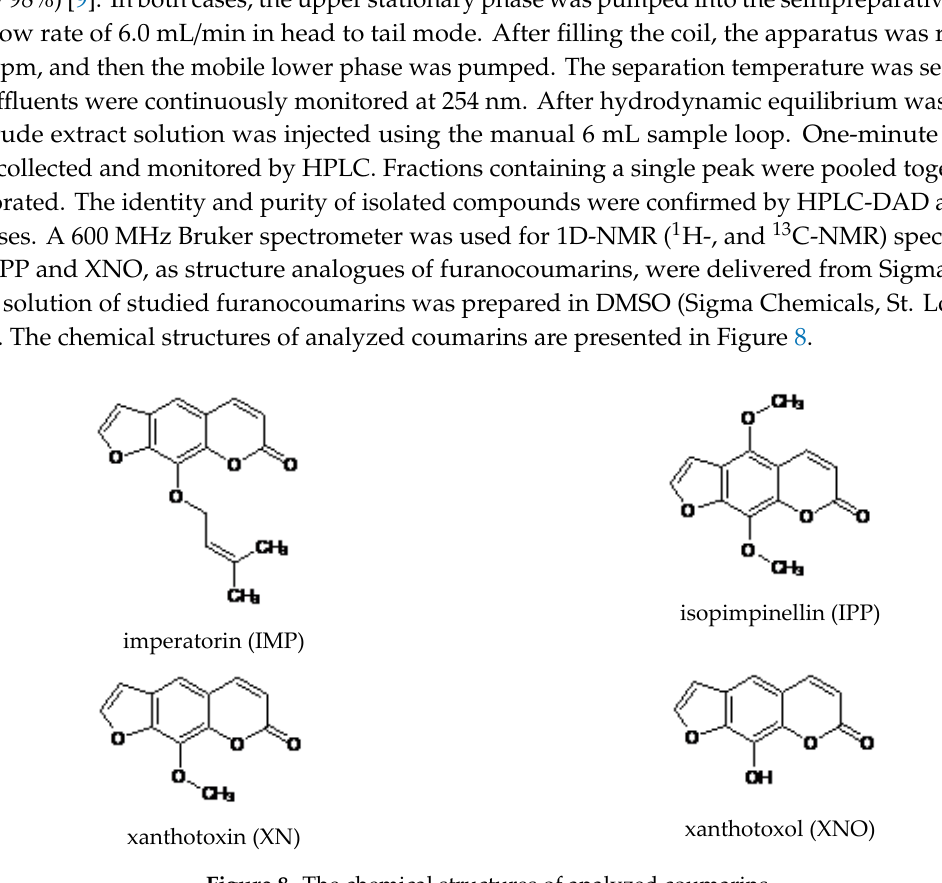
Figure 8. The chemical structures of analyzed coumarins.